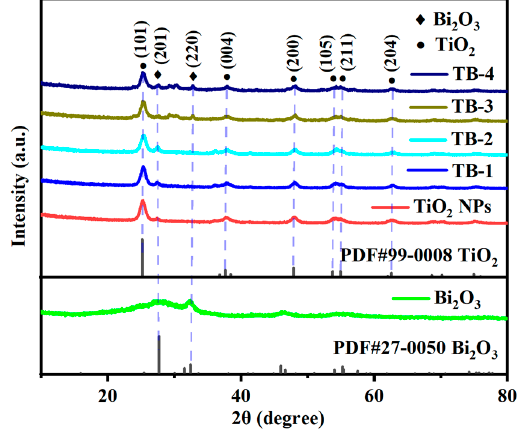
Figure 1. XRD spectra of TiO 2 NPs, Bi 2 O 3 , and TB-x (x = 1–4).